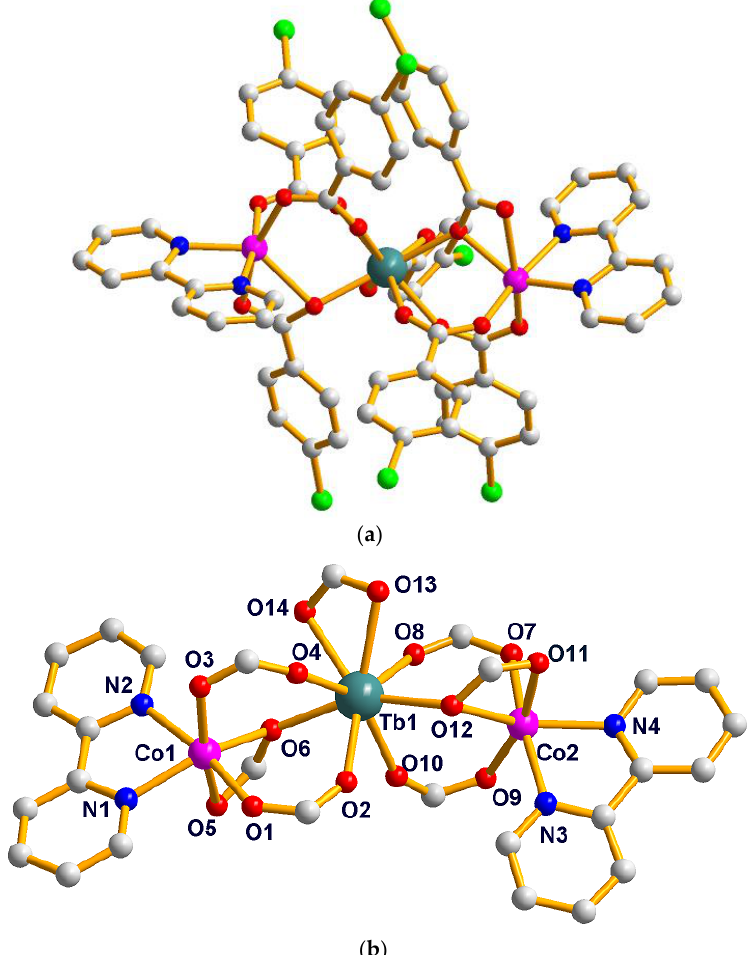
Figure 1. ( a ) The molecule structure of the trinuclear [TbCo 2 (L1) 7 (bipy) 2 ] of 5 . Hydrogen atoms are omitted for clarity. ( b ) The coordination environments of the metal centers in 5 .